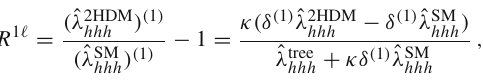
Fig. 7 Illustrations of the decoupling of the deviations of ˆ λ hhh calcu- lated in the 2HDM with respect to its SM prediction. ( Left side ): BSM deviations δ R 1 (cid:26) and δ R 2 (cid:26) – defined in Eq. (6.2) – respectively at one loop ( solid blue curve ) and at two loops ( dot-dashed red curve ) as a function of ˜ M . Results are shown for tan β = 1 . 5 and for several values of the difference M 2 Φ − ˜ M 2 = ˜ λv 2 , namely ( 200 GeV ) 2 , ( 300 GeV ) 2 , and ( 400 GeV ) 2 , where M Φ is the degenerate mass of the heavy 2HDM